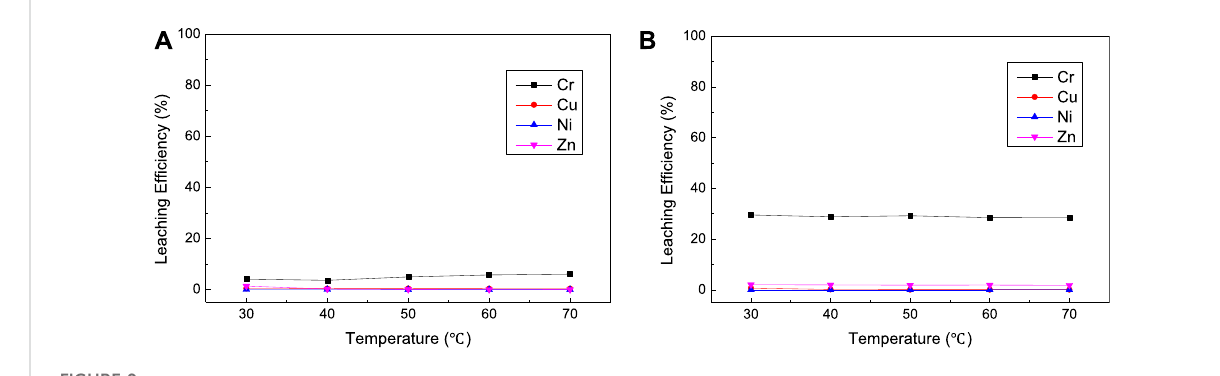
FIGURE 9 Effect of temperature on the leaching results [ (A) with H 2 O 2 ; (B) with NaClO] for complex sludge (EPS2).